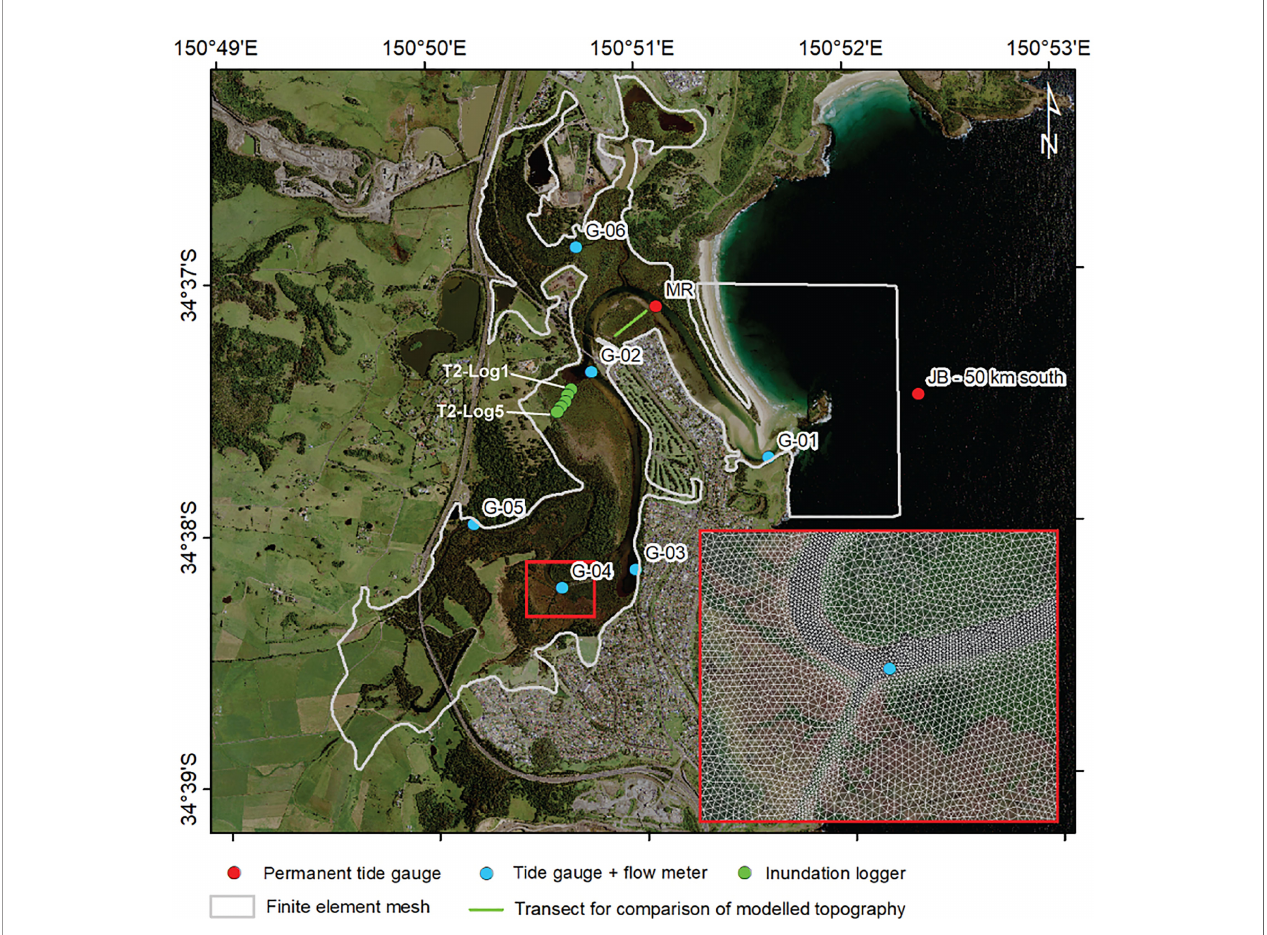
FIGURE 3 | Telemac2D fi nite element mesh model and location of tidal observations used for calibration and validation procedures. The grey polygon shows the extent of the Telemac2D model whereas the red box presents an example of the mesh-grid layout. The green transect indicates where modelled changes in wetland topography have been